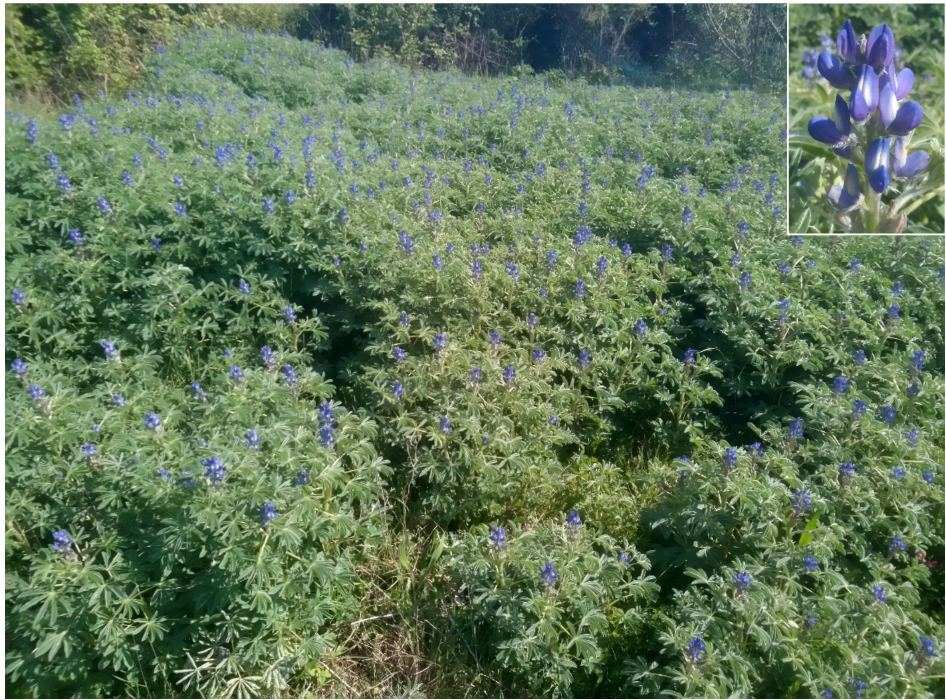
Figure 79. Lupinus albus subsp. graecus in Caffarella valley: new population found. Plumbago auriculata Lam. : this species was recently recorded in Latium (year 2016) as casual [107]. My discovery in the northeastern sector of Caffarella valley represents the second record for Latium. The population found occurs in shrubby vegetation dominated by Rubus ulmifolium and Sambucus nigra (Figure 80).